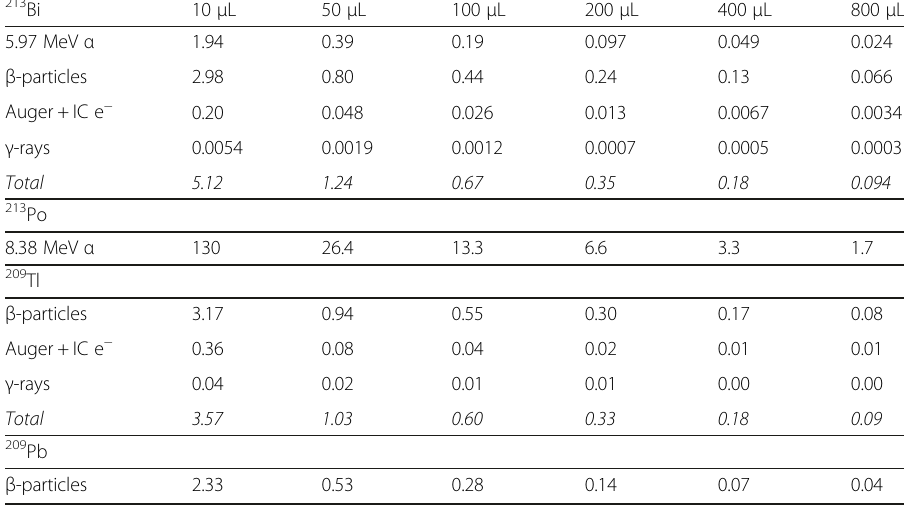
Table 2 Absorbed dose rates per unit activity (S-values, in mGy/MBq.s) in the reaction fluid for different volumes of 213 Bi, 213 Po, 209 Tl and 209 Pb. The different contributes to the S-value ( α , β , low energy electrons and γ -rays) are indicated separately